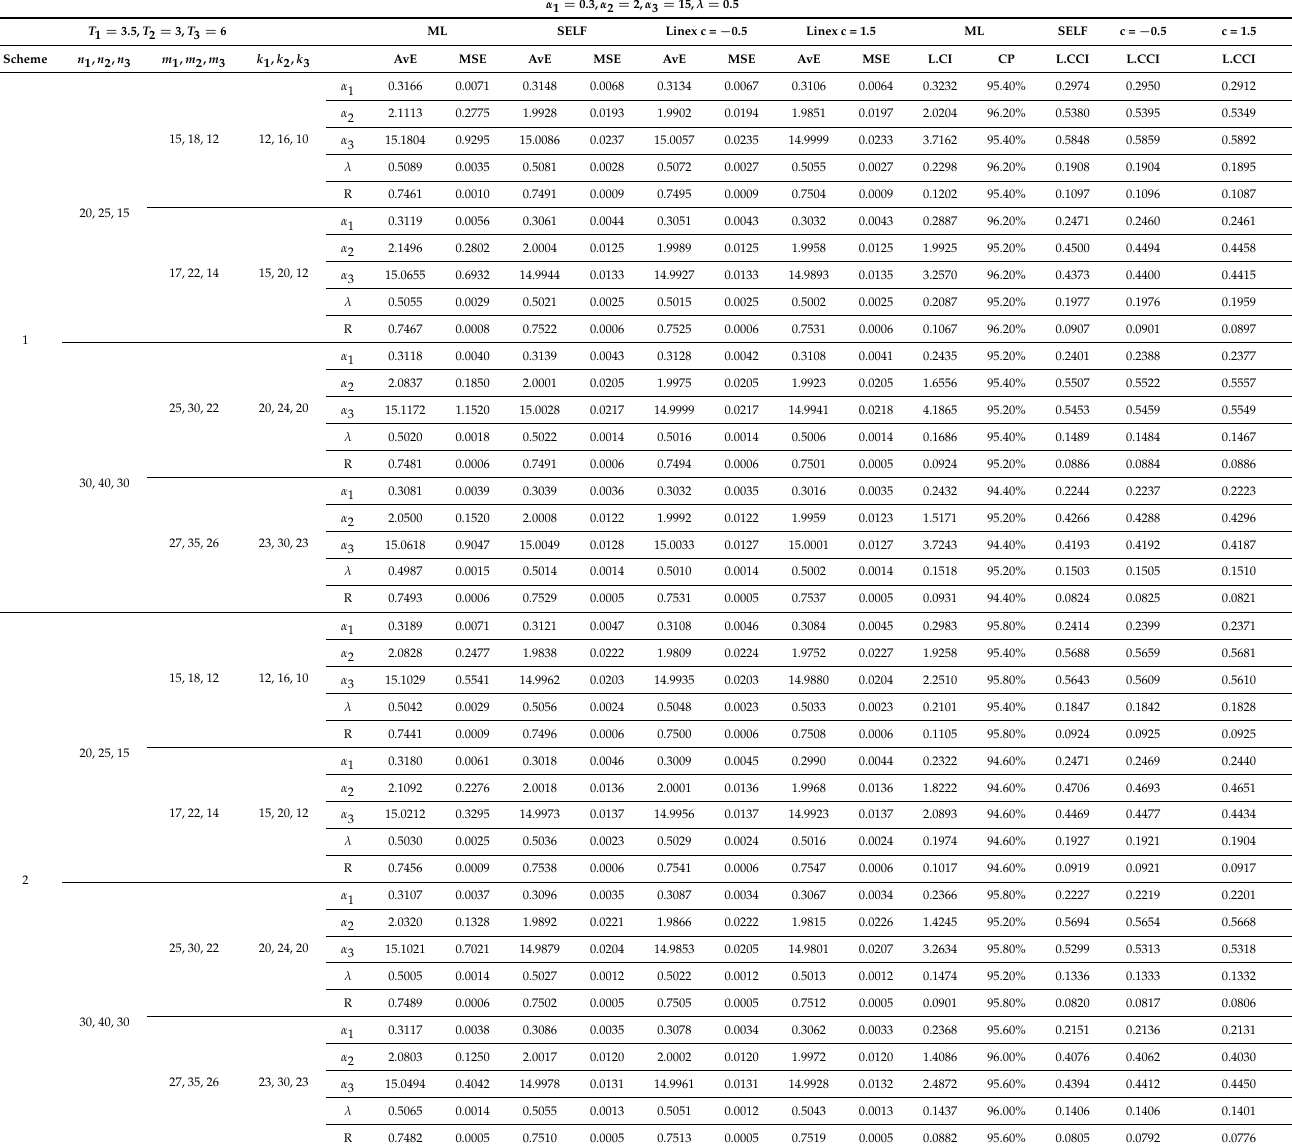
Table 4. AvE and MSE for estimation methods: Case